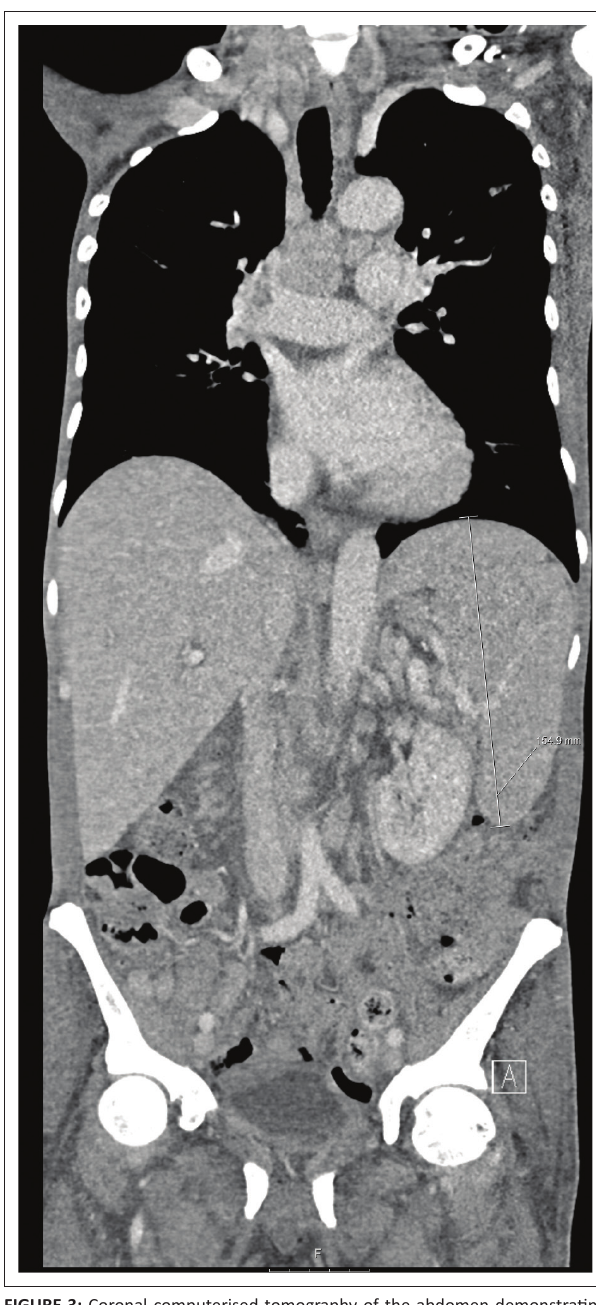
FIGURE 3: Coronal computerised tomography of the abdomen demonstrating